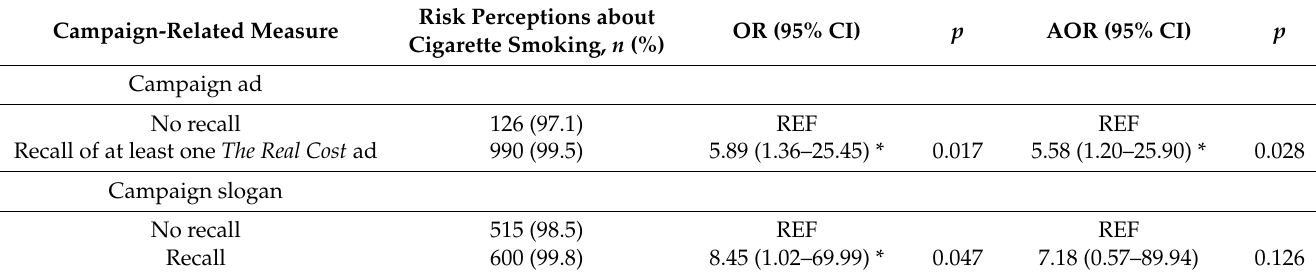
Table 3. Association between The Real Cost campaign recall and risk perceptions about cigarette